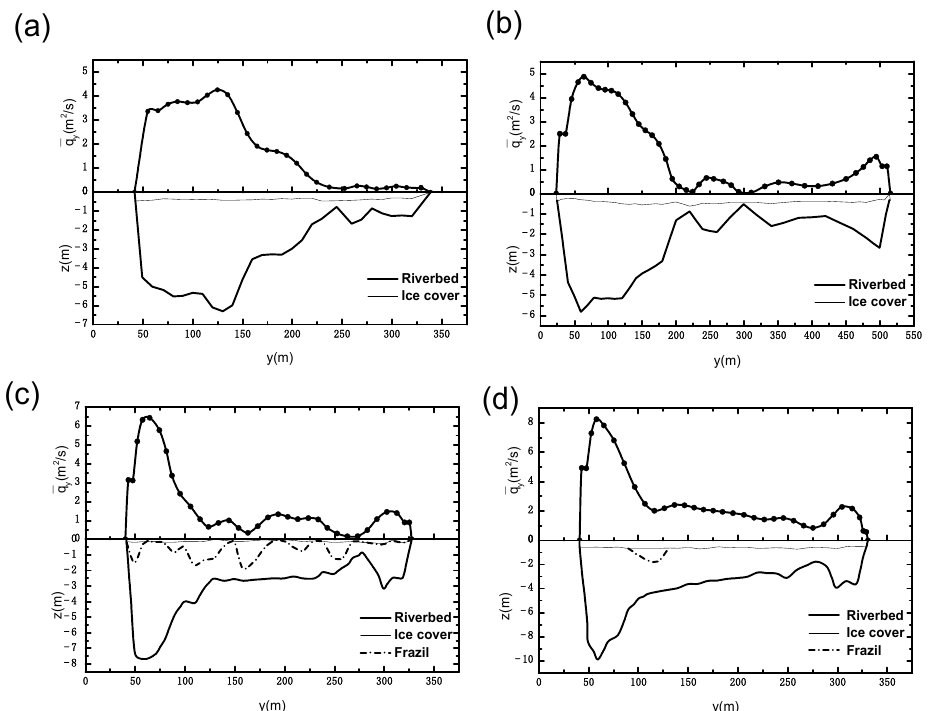
Figure 12. Section topography showing ice cover and riverbed distribution, and cross-sectional relative-unit discharge: ( a ) Baotou section on 26 January 2014; ( b ) Dabusutai section on 21 February 2014; ( c ) Baotou section on 14 December 2014; ( d ) Baotou section on 23 January 2015.